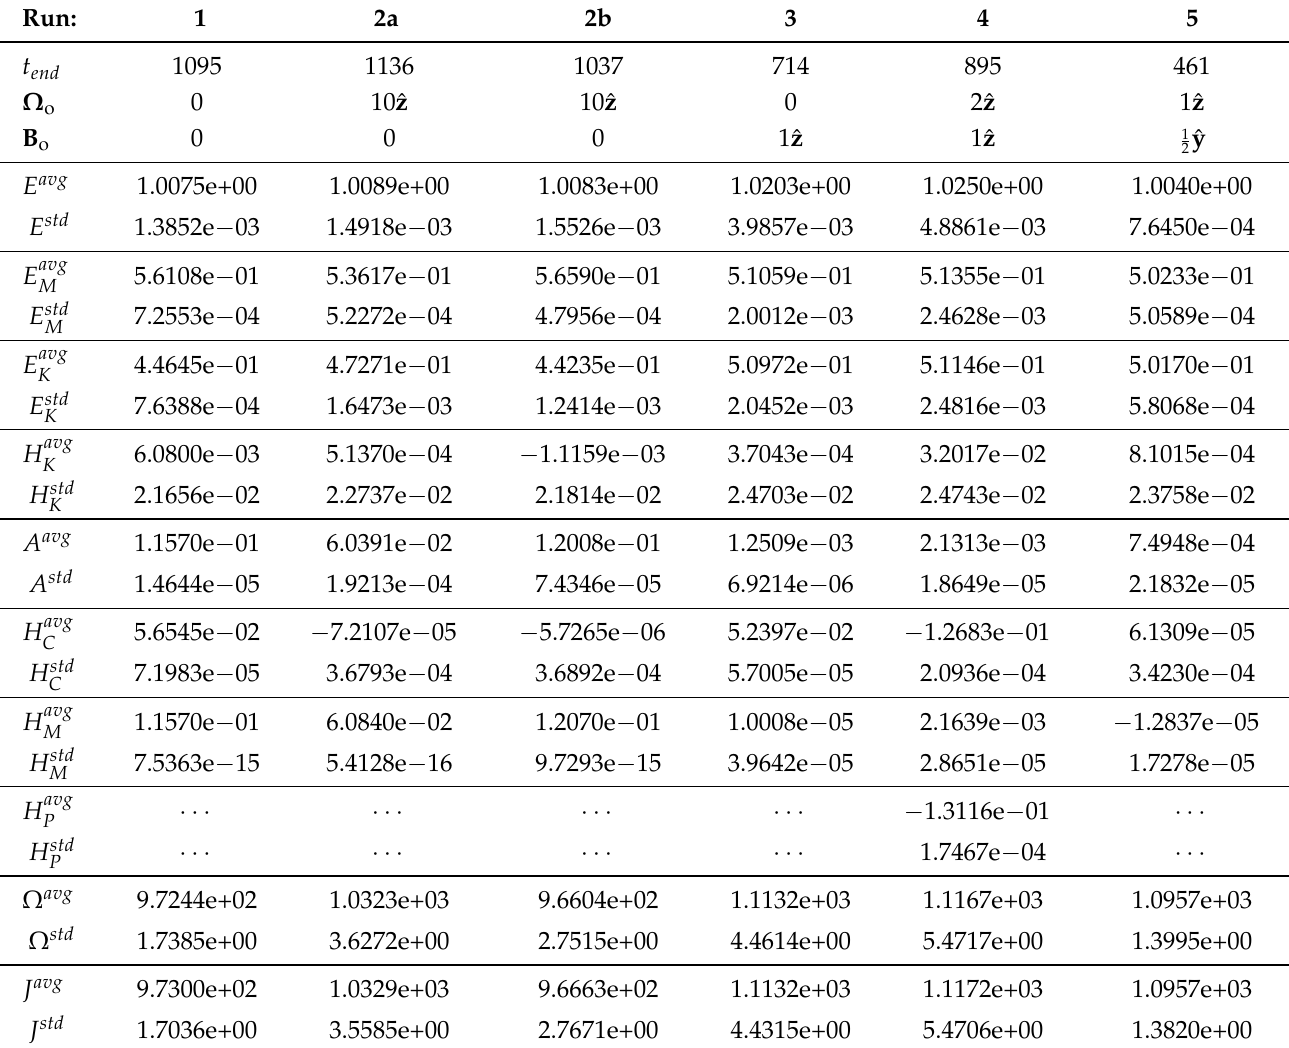
Table 2. Time averages and standard deviations (avg std) for various global quantities over the last ± half of each run are given below for six new ideal MHD turbulence long-time 128 3 runs A, B, C, D, E and F. These global quantities are: energy E , kinetic energy E K , magnetic energy E M , mean squared vector potential A , kinetic helicity H K , magnetic helicity H M , cross helicity H C , parallel helicity H P , enstrophy Ω and mean squared current J